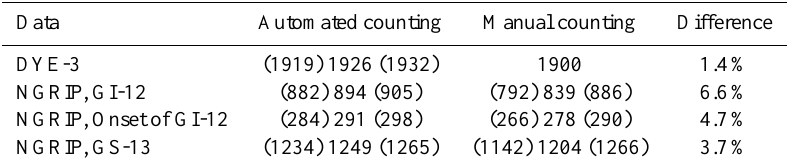
Table 1. Results from automated and manual annual layer counts. For the automated counting, the 95% confidence intervals (numbers in parentheses) are given based on the derived annual layer probability distributions. Note that these distributions are not necessarily symmetric around the most likely annual layer count. For the manual counting, the 95% uncertainty estimate is based on the maximum counting error (MCE) from the GICC05 chronology. For DYE-3, the ice core section is delimited by two absolute dated horizons (top of core, Vesuvius eruption), and hence no uncertainty is associated with the total number of layers in the interval.